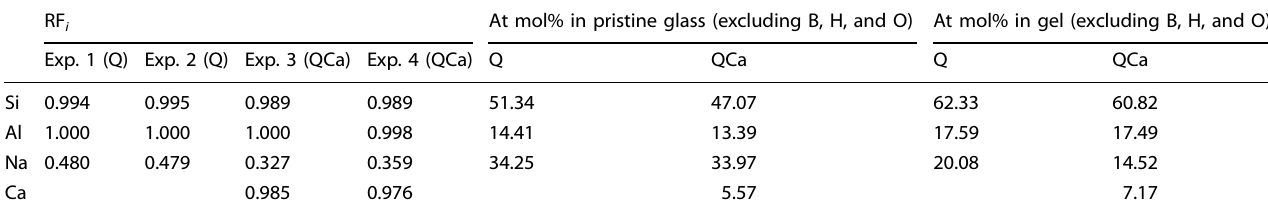
Table 2. Calculated retention factor of elements in the gel layer at the end of the experiment for the aqueous alteration experiments and composition of gel layer and pristine glass (excluding boron, oxygen and hydrogen). RF i At mol% in pristine glass (excluding B, H, and O) At mol% in gel (excluding B, H, and O)